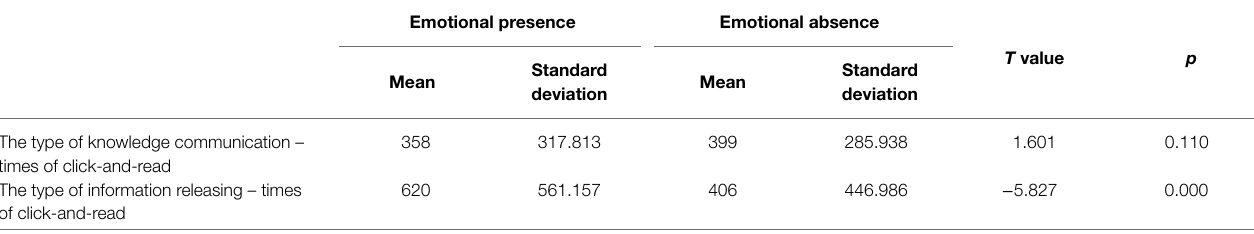
TABLE 3 | Independent sample t test results of the impact of the emotional presence of the tweet title on audience’s click-and-read behavior.